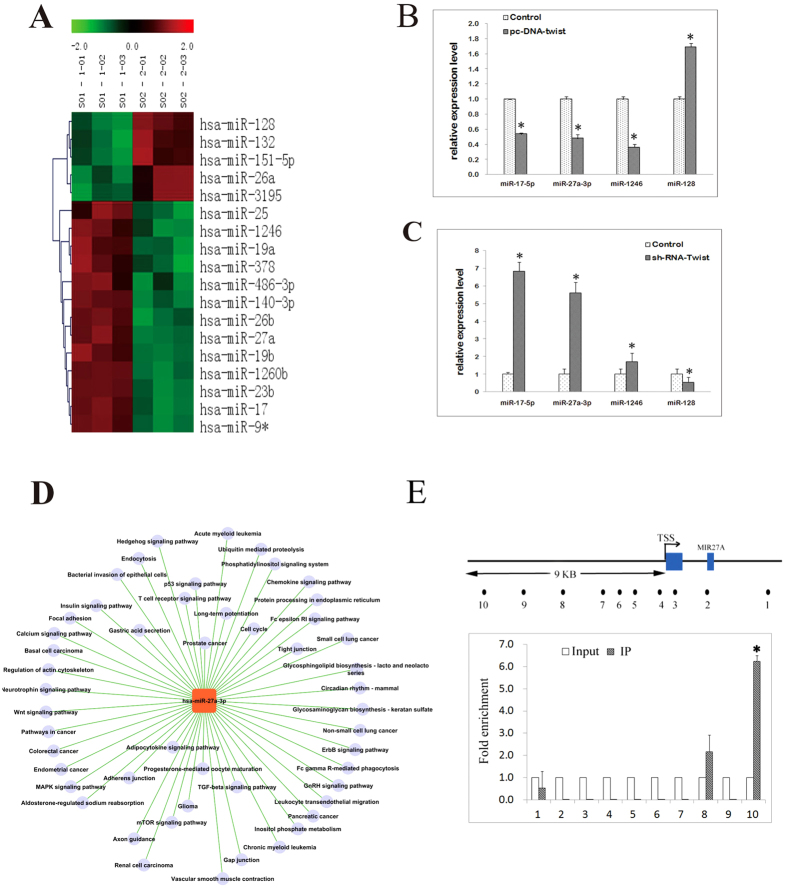
Twist-1 over-expression down-regulates the expression of miR-27a-3p.(A) Profile of miRNAs that were differentially expressed between HepG2-Twist-1 cells and HepG2-vector cells. The results were obtained from three paired samples. Both down-regulated (green) and up-regulated (red) miRNAs were identified in HepG2-Twist-1 cells compared to HepG2-vector cells. (B,C) Validation of the microarray data via real-time RT-PCR. Triplicate assays were performed for each RNA sample, and the relative quantity of each miRNA was normalized to the quantity of U6 snRNA. Statistically significant differences are indicated by *p < 0.01. (D) Microarray-based GO analysis revealed the roles of miR-27a-3p in HCC. (E) ChIP was performed on HepG2 cells transfected with pcDNA-Twi. The precipitated chromatin was PCR-amplified with the use of specific primers in the Pre-mir-27a promoter (Supplementary Table S3) as indicated by black dots. Bar graphs show fold enrichment of Twist-1 binding of MIR27A Transcription Start Site (TSS) region. Relative enrichment compared to irrelative antibody control is shown. The mean ± s.e.m of three determinations is shown. Data represent the mean ± SD of three experiments.